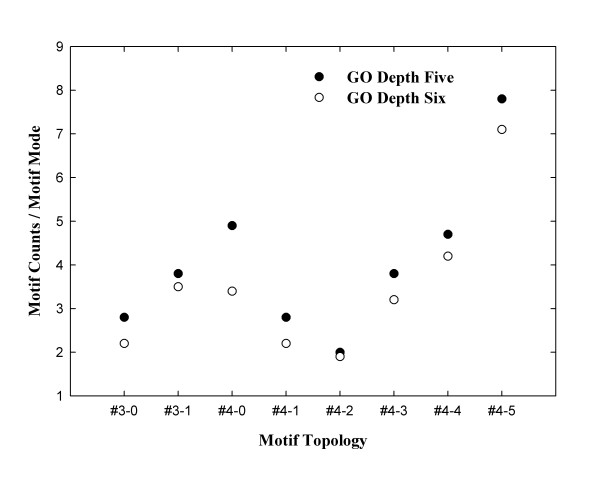
Average motif counts per motif mode of each motif topology in the yeast PPI network. Average motif counts per motif mode for each motif topology are indicated as filled and open circles when the GO terms at depths five and six were employed, respectively.